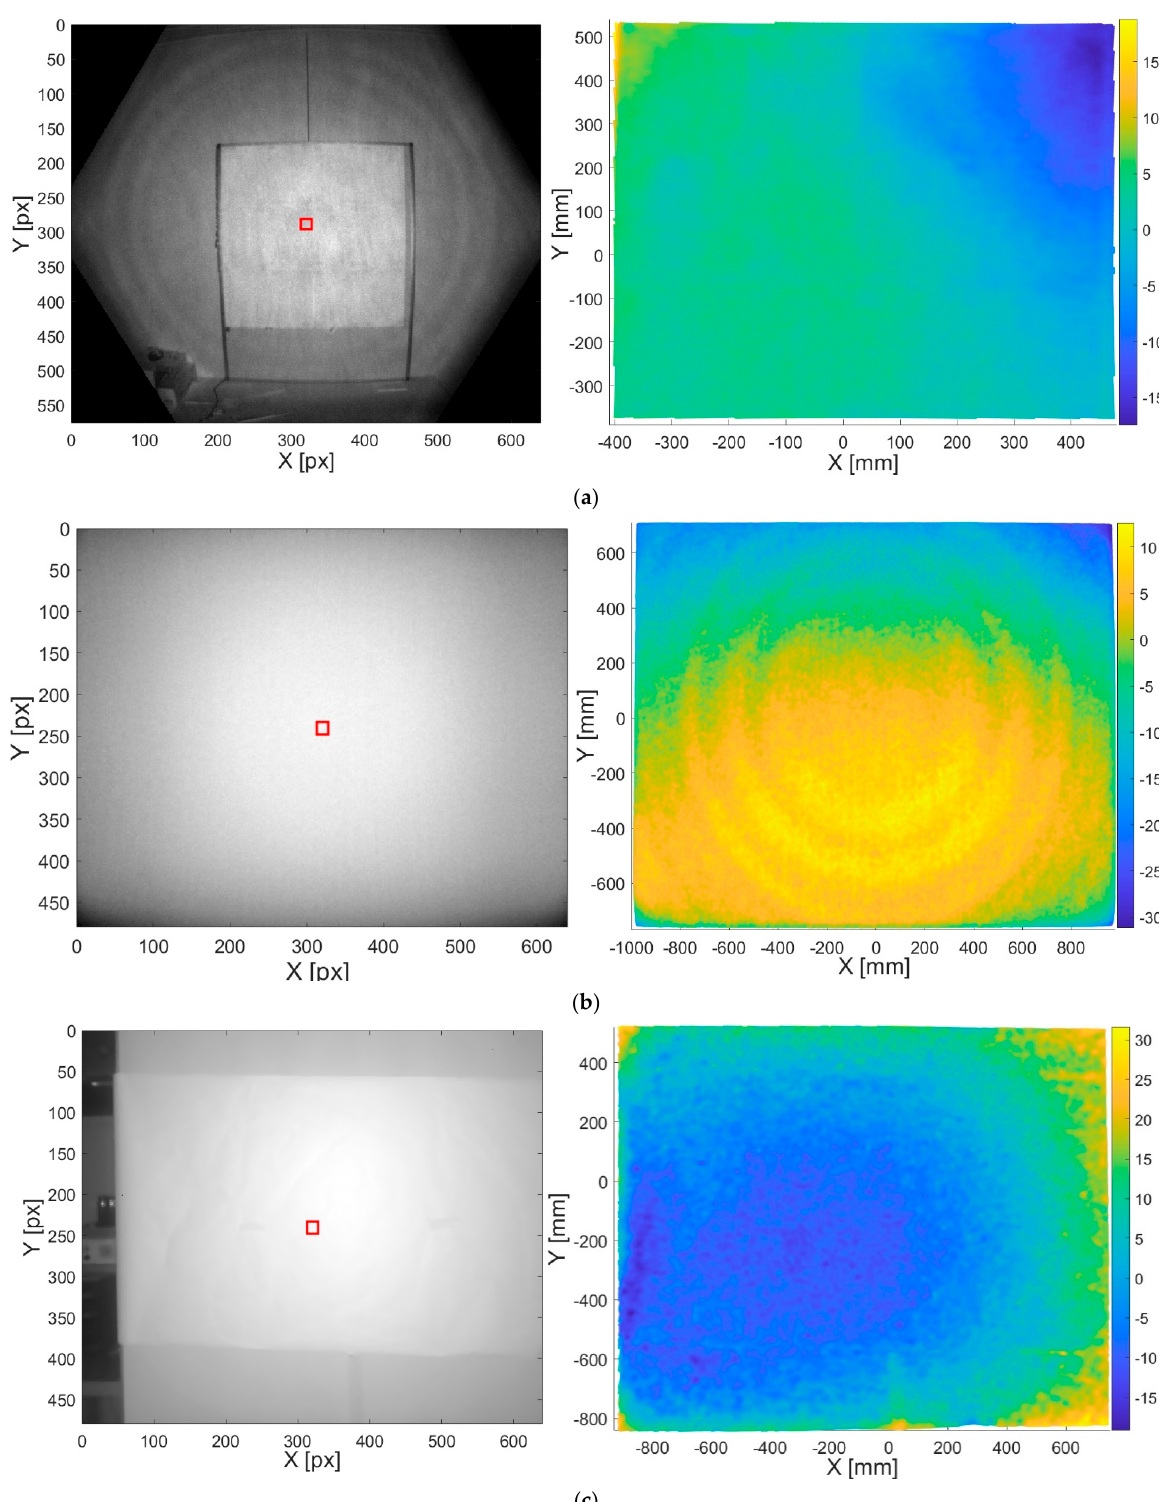
Figure 3. IR and Depth amplitude images of the target at D n = 1.7 m acquired with ( a ) Kinect Azure, ( b ) Basler Blaze 101, ( c ) Basler ToF 640. The central region of interest is shown in